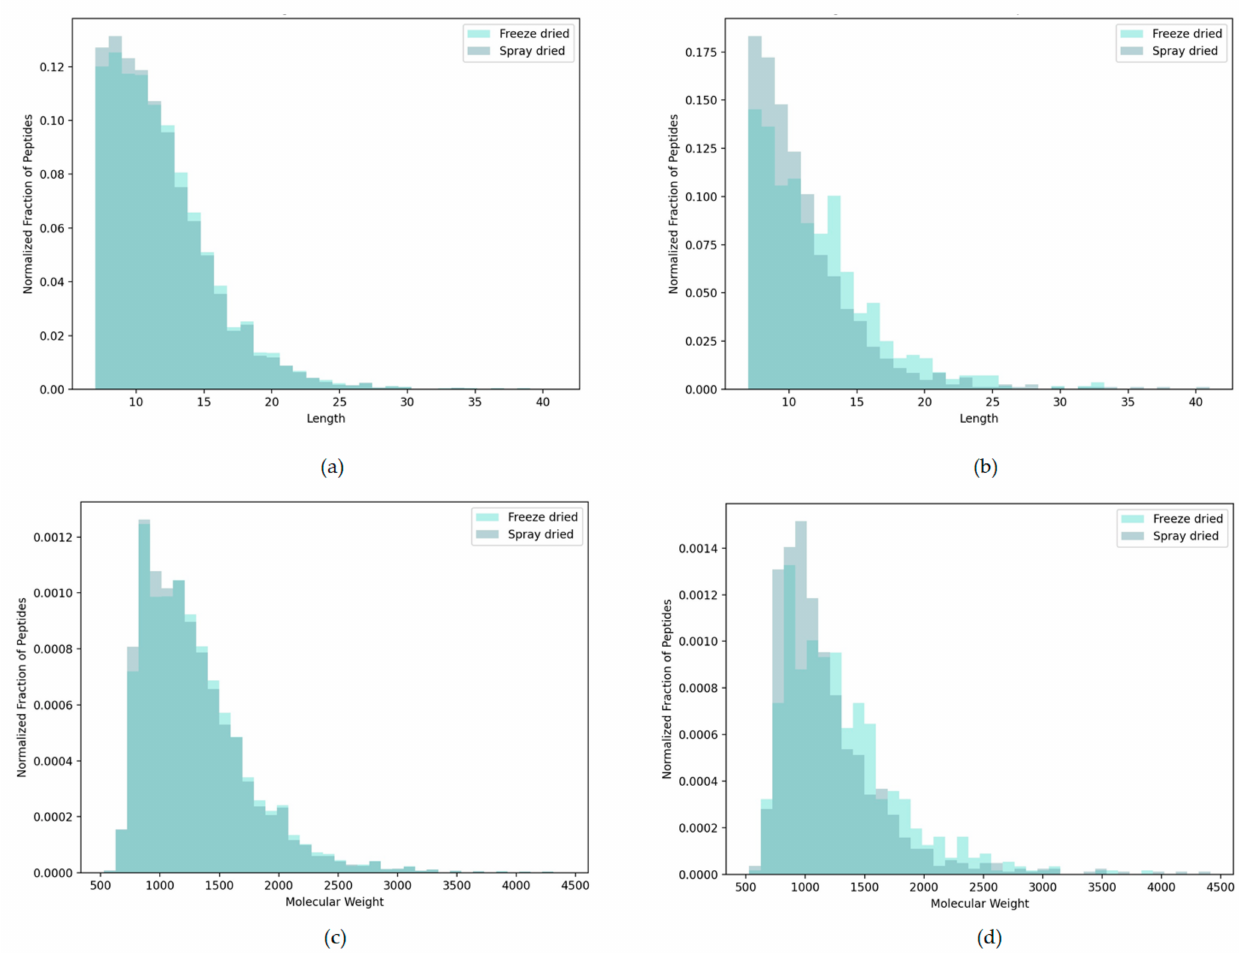
Figure 3. Peptide distribution according to length and molecular weight in FD and SD samples of rice NPN. The peptide profile as determined by LC-MS/MS in a histogram representation of rice NPN samples. Peptide distribution is according to length of amino acid chain in ( a ) peptides present in the total samples or ( b ) peptides exclusive in either FD (teal bar) or SD (blue bar) samples and according to weight (Da) in ( c ) peptides present in full samples or ( d ) peptides exclusive in either FD or SD samples, all data is normalised for